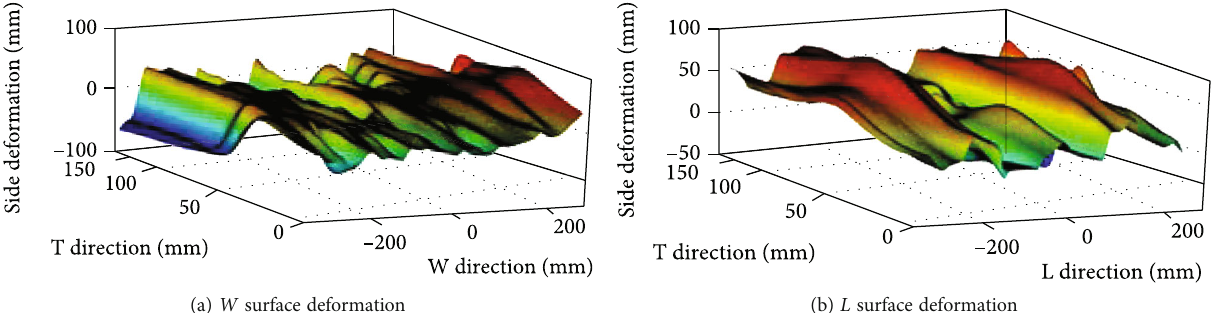
Figure 12: W and L surface deformation fi tting diagram.